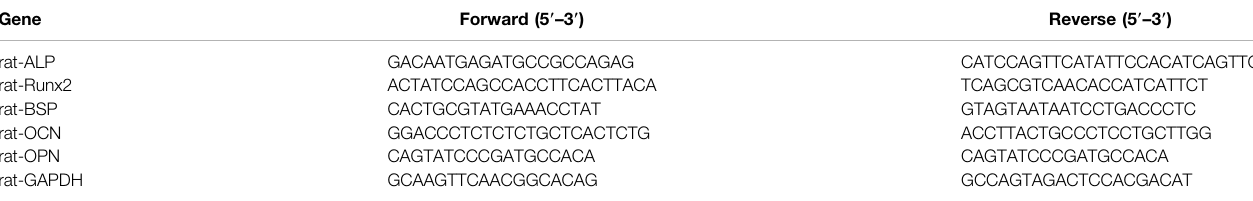
TABLE 1 | Primer sequences for real-time